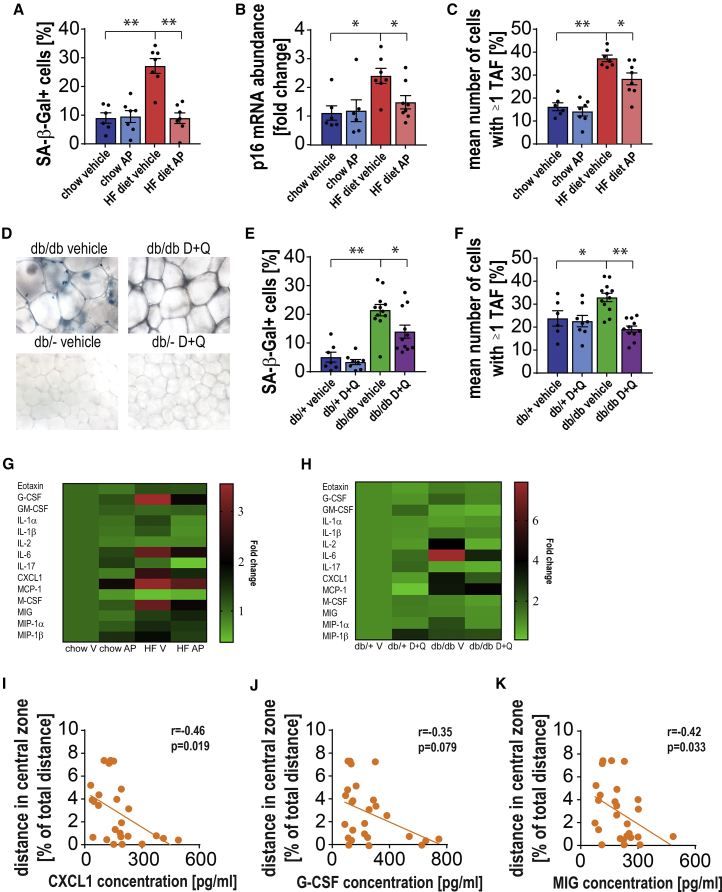
Clearance of Senescent Cells from Obese Animals Reduces Circulating Cytokine Levels(A) Quantification of percentage of senescence-associated beta-galactosidase (SA-β-Gal)-positive cells in perigonadal adipose tissue shows increased values in HFD-fed animals and complete rescue after treatment with AP20187 (t(11) = 5.563, p = 0.0002; t(12) = 5.739, p < 0.0001).(B and C) Senescence markers (B) p16 (measured by RT-PCR) (U = 5, p = 0.0221; t(13) = 2.631, p = 0.0208) and (C) telomere associated DNA damage foci (TAF) (t(11) = 9.495, p < 0.0001; t(13) = 2.913, p = 0.0121) show a similar pattern.(D and E) (D) Representative images and (E) quantification of SA-β-Gal activity in perigonadal adipose tissue of db/db and db/+ mice shows that the percentage of SA-β-Gal-positive cells increases in db/db mice compared to db/+ and is significantly reduced after treatment with the senolytic cocktail, D+Q (t(17) = 5.615, p < 0.0001; t(21) = 2.504, p = 0.0206).(F) Frequencies of TAF-positive cells in perigonadal adipose tissue of db/db mice increased significantly in comparison to db/+ mice and decreased after D+Q treatment (t(16) = 2.612, p = 0.0189; t(21) = 5.937, p < 0.0001).(G) Cytokine protein expression [fold change] in blood plasma from HFD animals treated with/without AP20187.(H) Cytokine expression [fold change] in blood plasma from db/db animals treated with/without AP20187.(I–K) Linear regression analysis between anxiety markers and cytokines in blood plasma showed a significant negative correlation between (I) Cxcl-1 (r = −0.4663, p = 0.0188), (J) G-Csf (r = −0.3507, p = 0.079), (K) Mig (r = −0.4205, p = 0.0325), and the distance traveled in the central zone of the OF box in HFD-fed mice.Data are from n = 6–9 mice per group for (A)–(C) and (G); n = 7–12 mice per group for (E), (F), and (H); n = 27 mice per group for (I)–(K). Mean ± SEM plotted. ∗p ≤ 0.05 and ∗∗p ≤ 0.001.